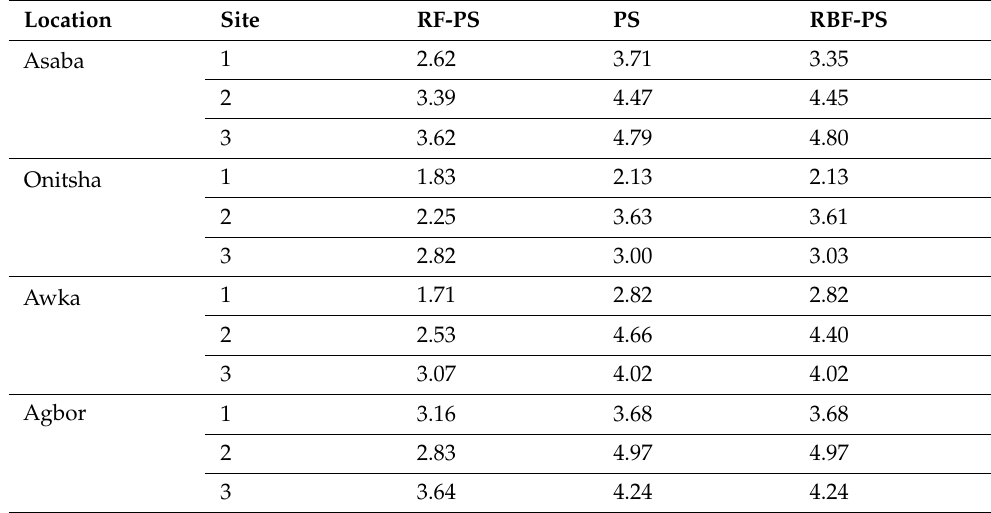
Table 3. The Coefficients of the developed path loss model using the proposed hybrid RF-PS and other existing standard approaches.